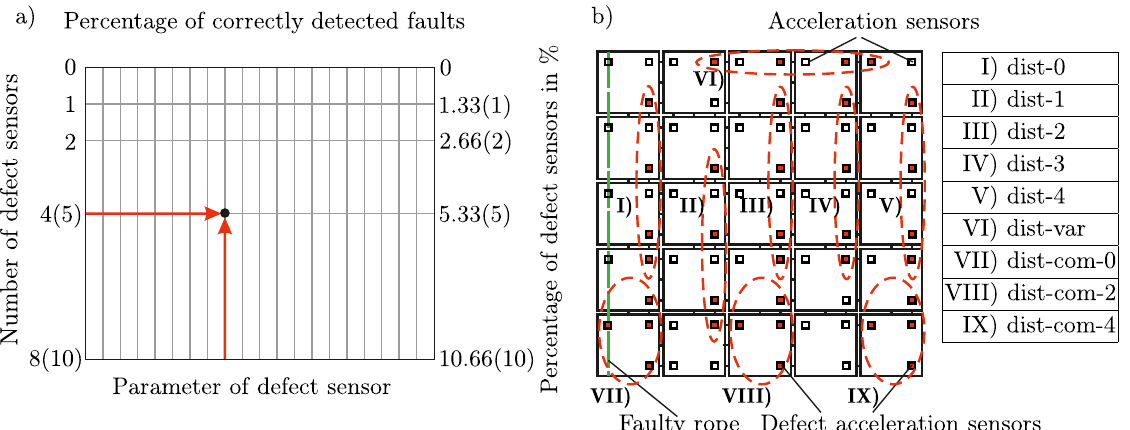
Figure 8. ( a ) Array of the percentage of correctly detected rope faults as a function of number, percentage and parameters of defect sensors for 3 and (4) z acceleration sensors. ( b ) Examples of different distances between 4 defect sensors, a rope fault in rope number 1 and 3 z acceleration sensors per